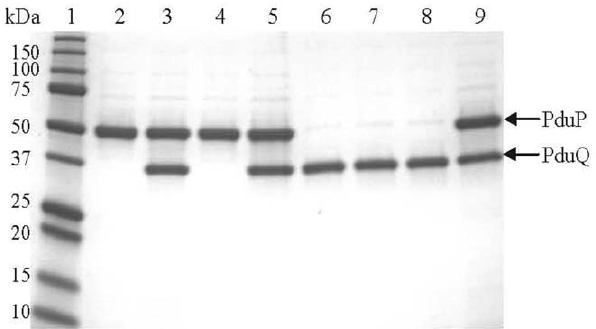
Figure 7. His-tag protein affinity pull-down assays indicated binding between PduQ and PduP. Lane 1, protein standards; lane 2, His 6 -PduP; lane 3, His 6 -PduP + PduQ; lane 4, PduP-His 6 ; lane 5, PduP- His 6 + PduQ; lane 6, His 6 -PduQ; lane 7, His 6 -PduQ + PduP; lane 8, PduQ- His 6 ; lane 9, PduQ-His 6 + PduP.